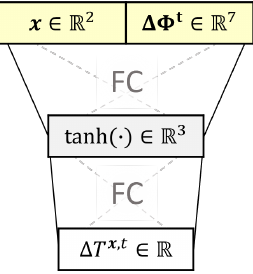
Figure 2. Architecture of ∆ T x ,